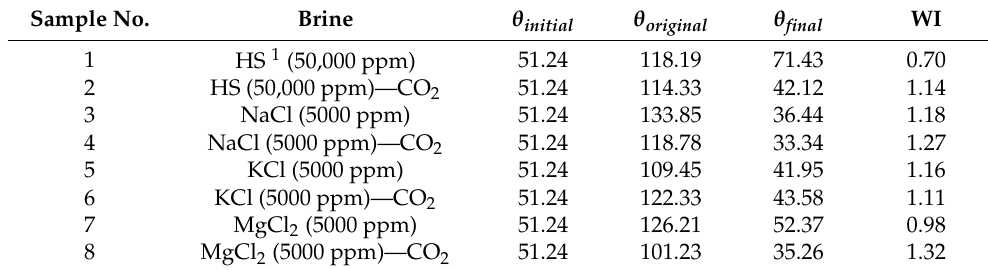
Table 8. Value of contact angle and wettability index [97,123]. Sample